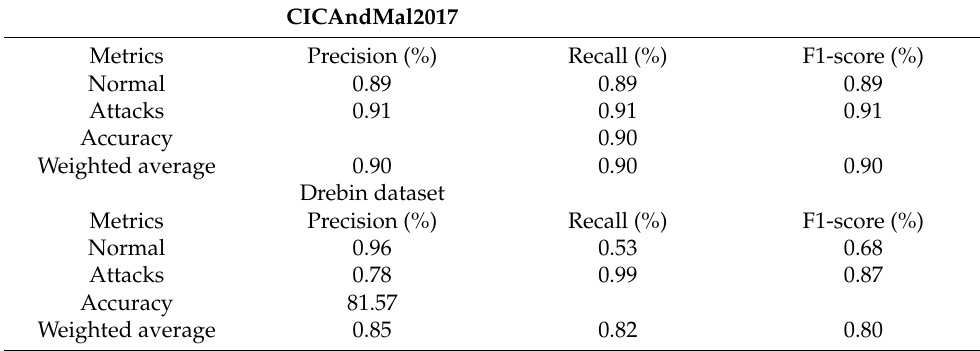
Table 6. Results of KNN algorithm.